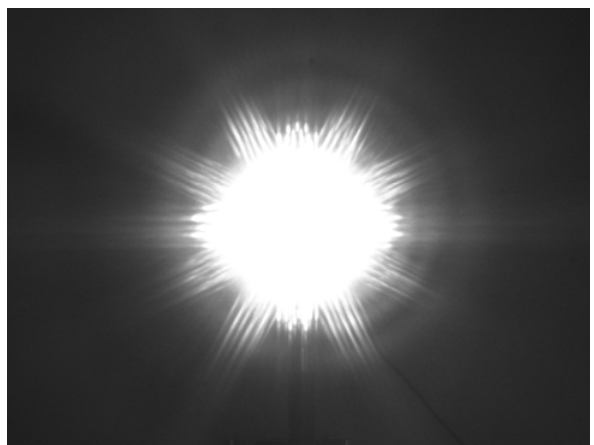
Figure 5. Image as taken by the video theodolite from point 2